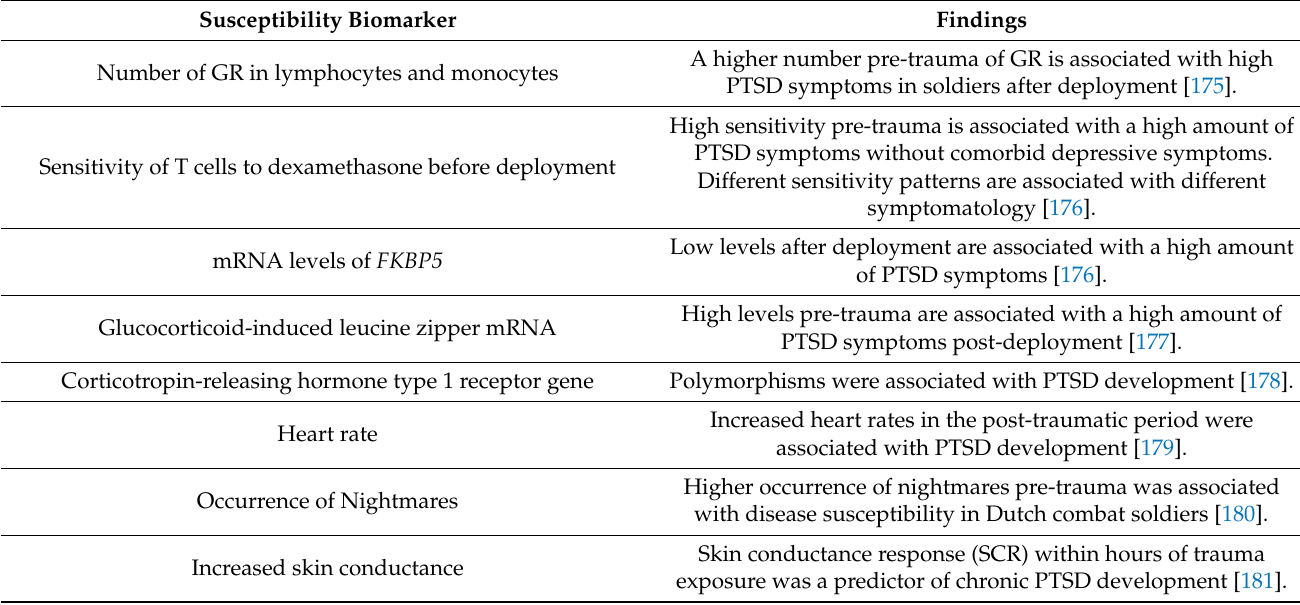
Table 2. Summary of the susceptibility biomarkers implicated in